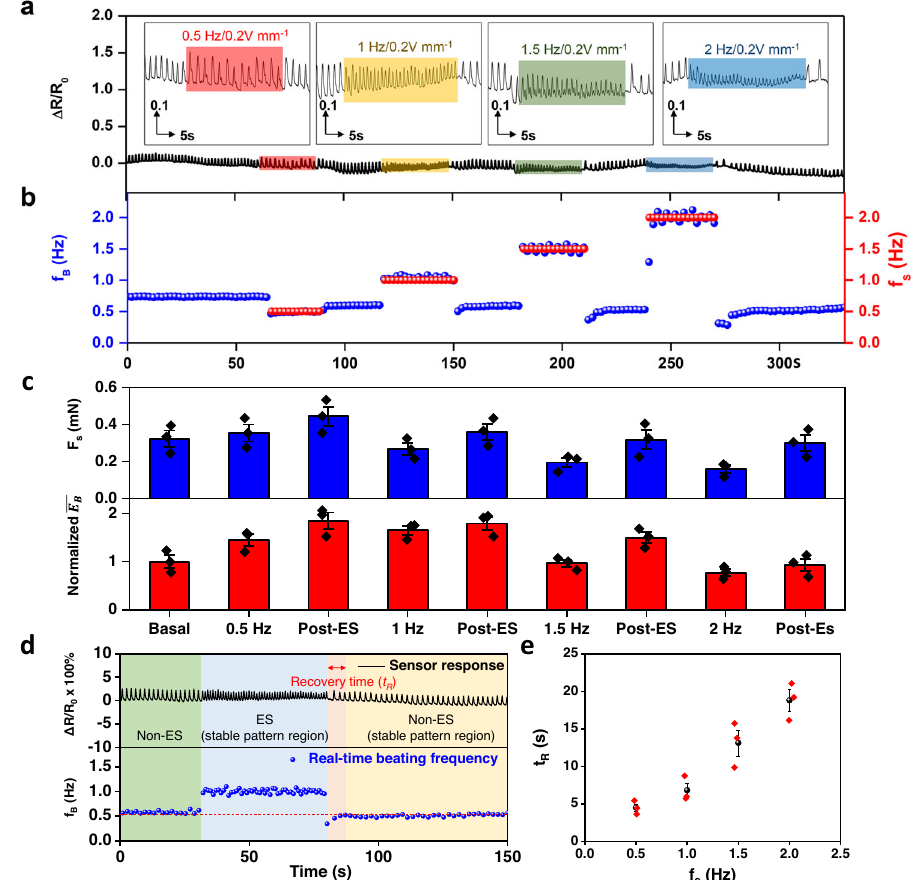
Fig. 3 | Instantaneous measurement of cardiac organoids during electrical stimulation in ambient conditions. a Real-time resistance changes of the sensor duringperiodsofESwithdifferentfrequencies.lefttoright:0.5Hz,1Hz,1.5Hz,and 2Hz with an electrical fi eld strength of 0.2Vmm − 1 ; b Real time beating frequency changes of the organoid (blue dot) during electrical stimulation (red dot). c The